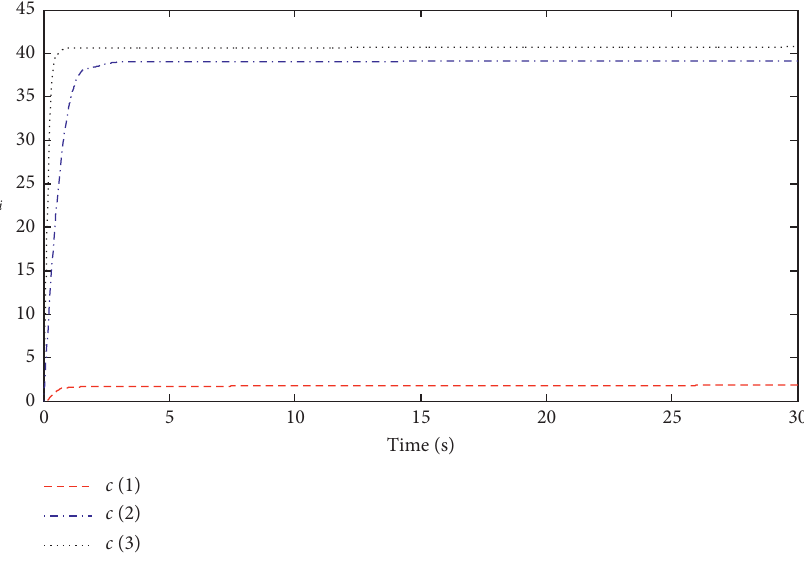
Figure 8: The output of the robust adaptive